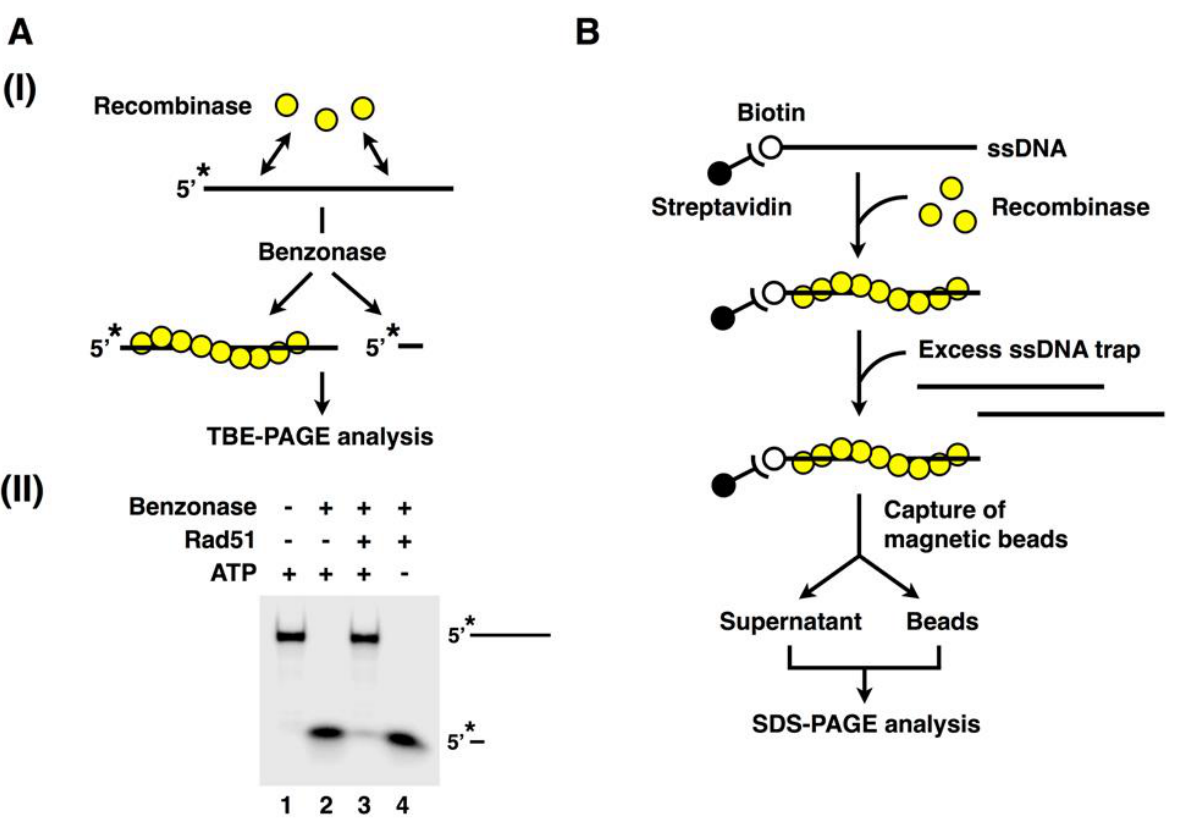
FIGURE 8: Endonuclease protection assay. (A) A schematic representation of endonuclease protection assay in ( i ). Assembly of S. cere- visiae Rad51 filaments was analyzed with ATP or no nucleotide as cofactor in ( ii ). (B) Schematic of biotinylated-ssDNA bead-based